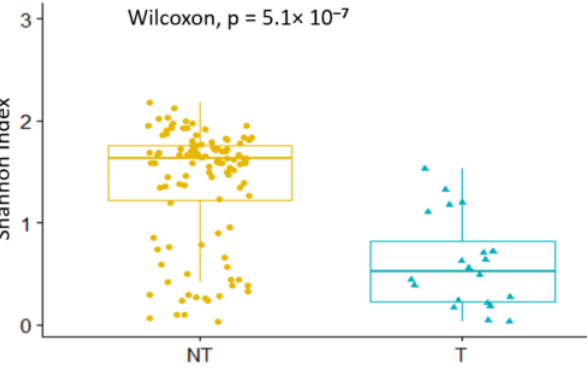
9 of 18 Figure 4. Microbiome diversity in different tsetse species (Gtach: Glossina tachinoides ; Gpp: G. palpalis palpalis ; Gcal: G. caliginea ; Gpal: G. pallicera pallicera ). 3.5.2. Diversity in Non-Teneral and Teneral Glossina palpalis palpalis In non-teneral tsetse flies of the species G. palpalis palpalis , the top represented bacteria